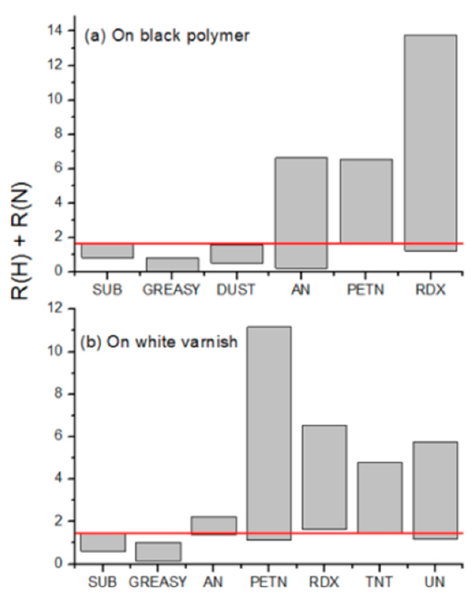
Figure 11. Span of the LIBS measured sum S of the ratios R(H) = I 1 (H)/I 2 (H) and R (N) = I 1 (N)/I 2 (N) on different fingerprints placed over black polypropylene ( a ) or white varnished metal ( b ). The red line indicates the lower threshold established for the detection of nitro-compounds. X axis: SUB is clean substrate, AN is ammonium-nitrate, and UN is urea-nitrate.